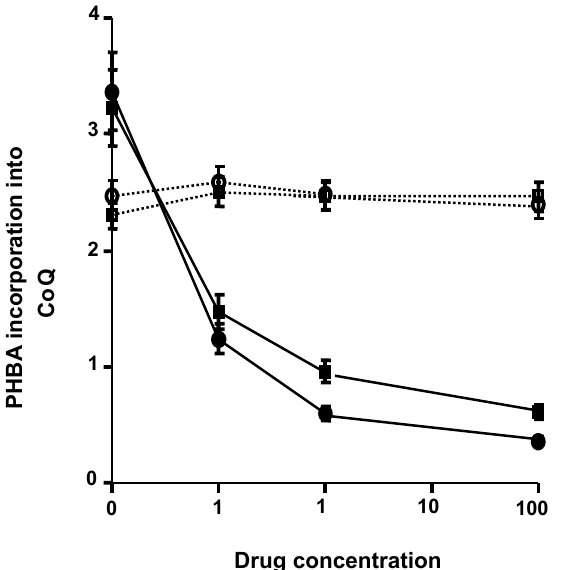
Fig. 3. – incorporation of [U- 14 C] p -hydroxybenzoate (PhBa) into total ubiquinones in both the mitochondrial and microsomal P. carinii subcellular fractions. The CoQ analogs atovaquone and buparva- quone inhibited microsomal but not mitochondrial CoQ synthesis. Dashed lines, mitochondrial fraction; solid lines, microsomal fraction; squares, atovaquone; circles, buparvaquone.